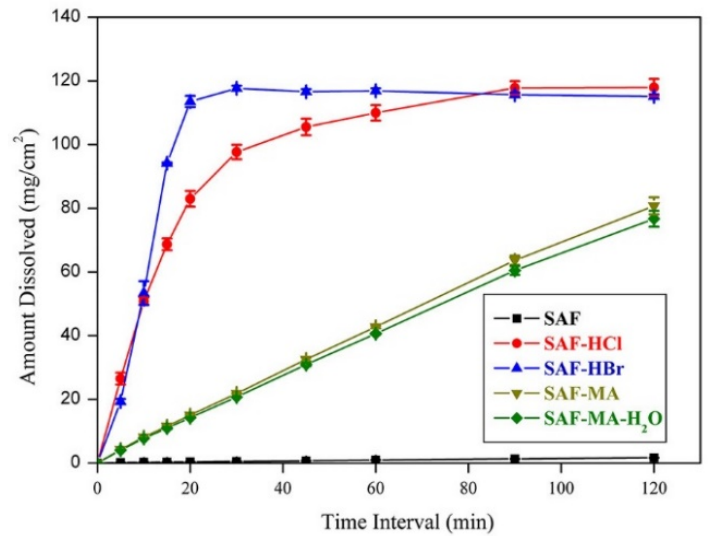
Figure 9. Dissolution profiles for SAF, SAF-HCl, SAF-HBr, SAF-MA, and SAF-MA-H 2 O in water at 37 ◦